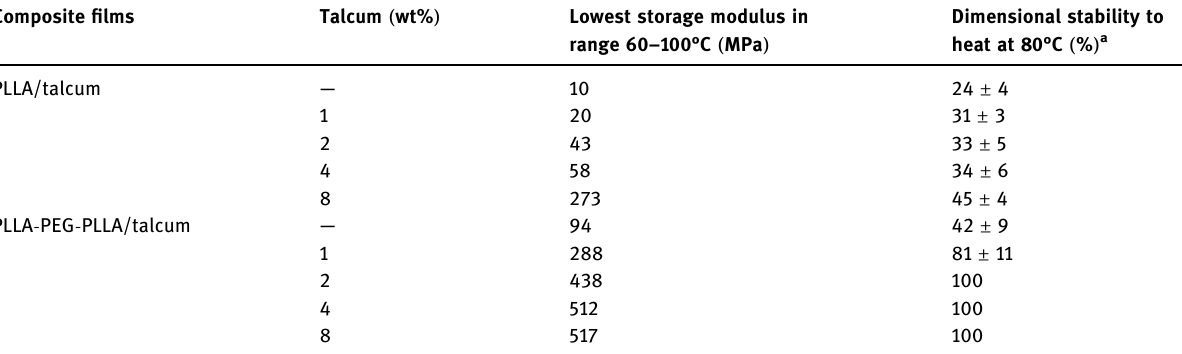
Table 3: Lowest storage modulus and dimensional stability to heat of PLLA/talcum and PLLA - PEG - PLLA/talcum fi